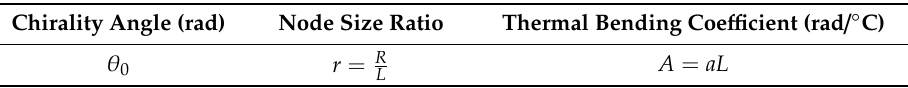
Table 1. Independent structural parameters of the antichiral metamaterial.